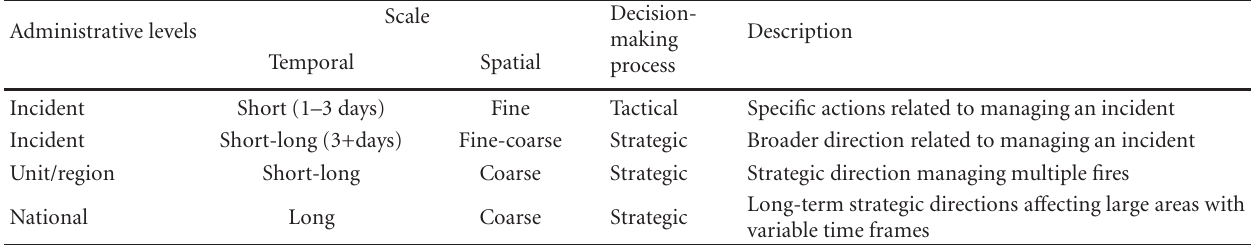
Table 1: Administrative levels and spatial and temporal scales of the decision-making process in WFDSS. Administrative